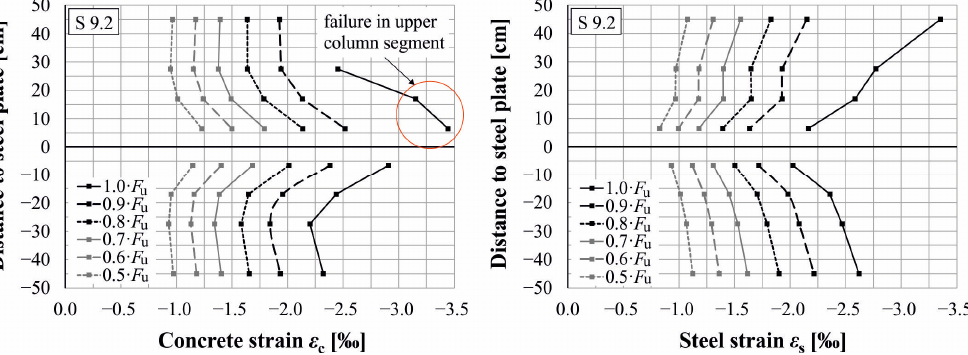
Figure 12. Measured concrete ( left ) and steel stains ( right ) above and below the butt joint for S 9.2.